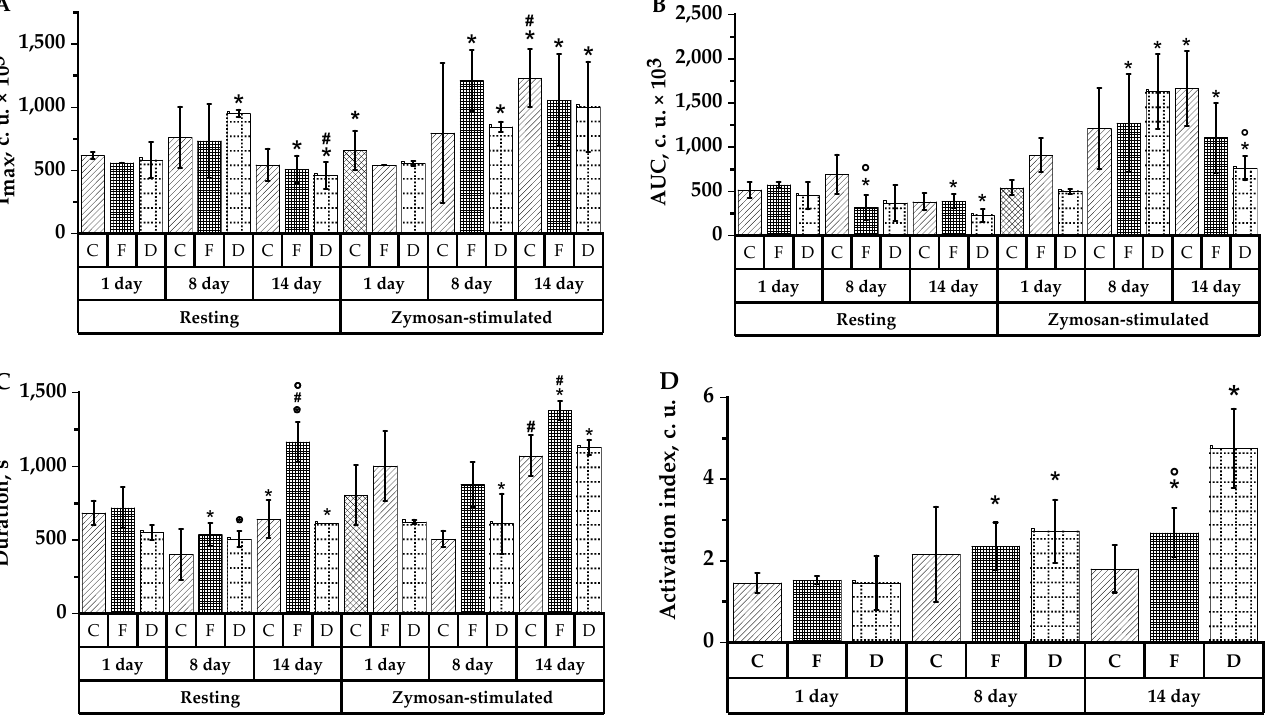
Figure 6. Spontaneous and zymosan-stimulated chemiluminescence indices of rat neutrophils of groups C, D and F: ( A ) CL intensity (I max ); ( B ) area under CL curve (S); ( C ) time to reach maximum CL intensity (T max ); ( D ) activation index (I act ). * ( p < 0.05)—reliability of differences in animal groups compared with 1 experimental day; # ( p < 0.05)—differences reliability in animal groups compared with 8 experimental days; ° ( p < 0.05)—differences reliability between animal groups compared with the control group.